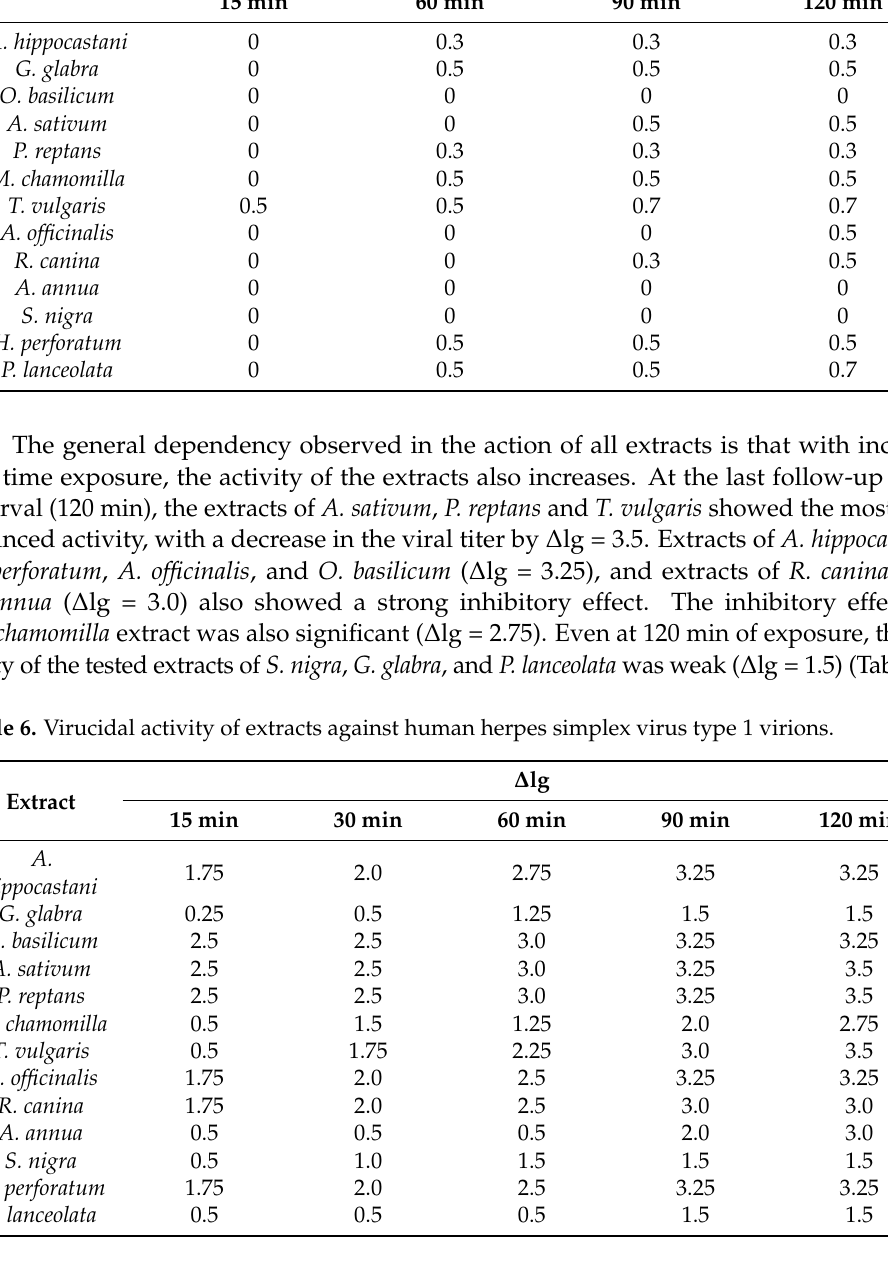
Table 5. Virucidal activity of extracts against human adenovirus virions. Extract